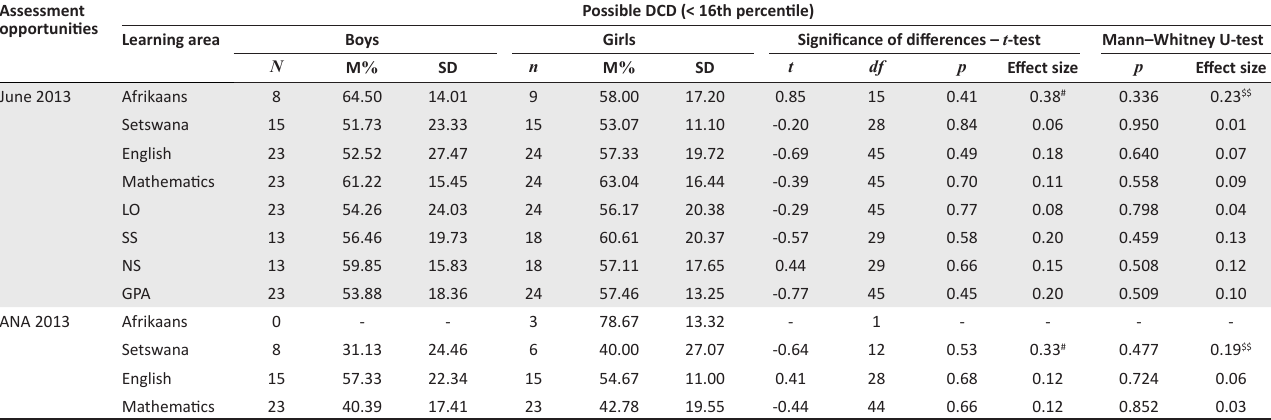
TABLE 5: Gender differences in academic achievement of learners with possible developmental coordination disorder (< 16th percentile). Assessment opportunities